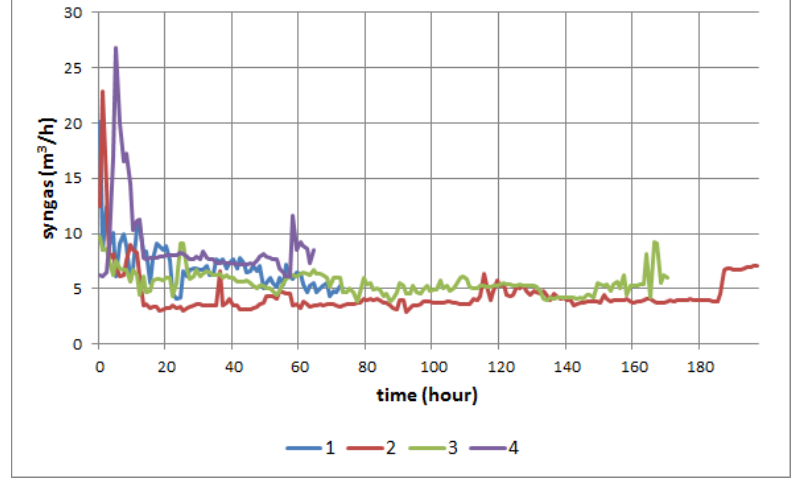
Figure 5. The volume flow of syngas for individual experiments.